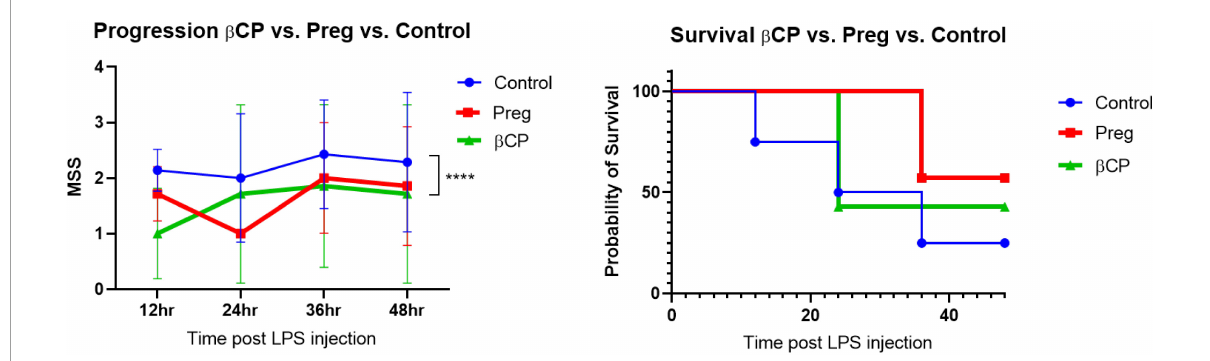
FIGURE1 All groups were injected with LPS 25 µ g/g. Mice were pre-treated with β -caryophyllene (BCP, 25 mg/kg) or Pregnenolone (Preg, 10 mg/kg) 24 and 12 h before LPS injection and then every 12 h. N = 7. **** p < 0.0001, 2-way ANOVA between β CP and Controls.